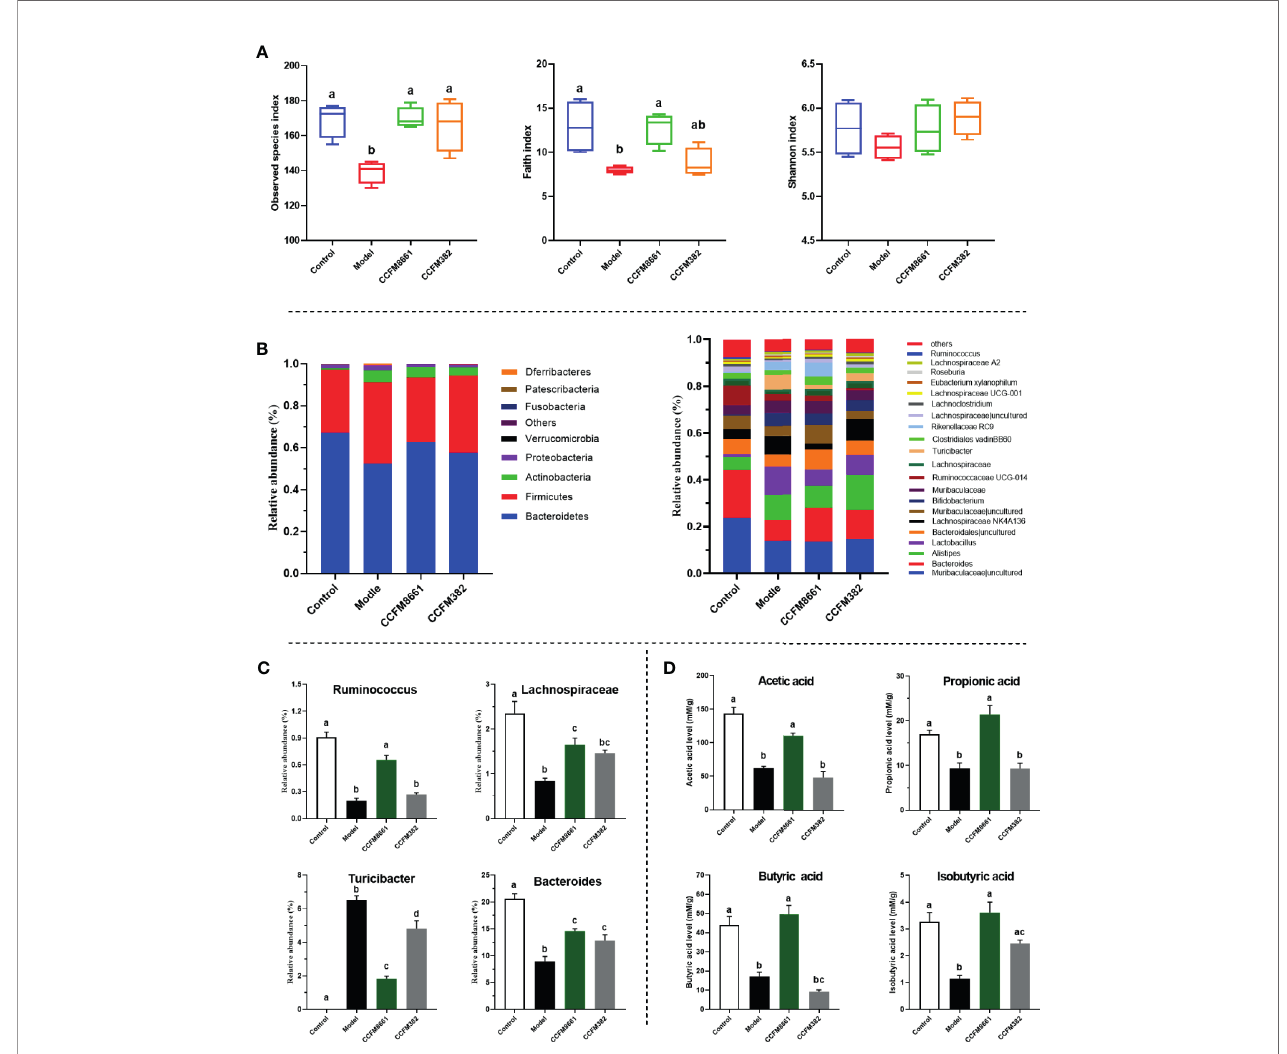
FIGURE 6 | Effect of L. plantarum CCFM8661 on the diversity and composition of the gut microbiota and SCFA levels. (A) a -diversity, (B) relative abundance of constituents of the gut microbiota at the phylum and genus levels, (C) relative abundance of signi fi cant bacterial communities, (D) SCFA levels. The different letters indicate signi fi cant difference between groups ( P < 0.05